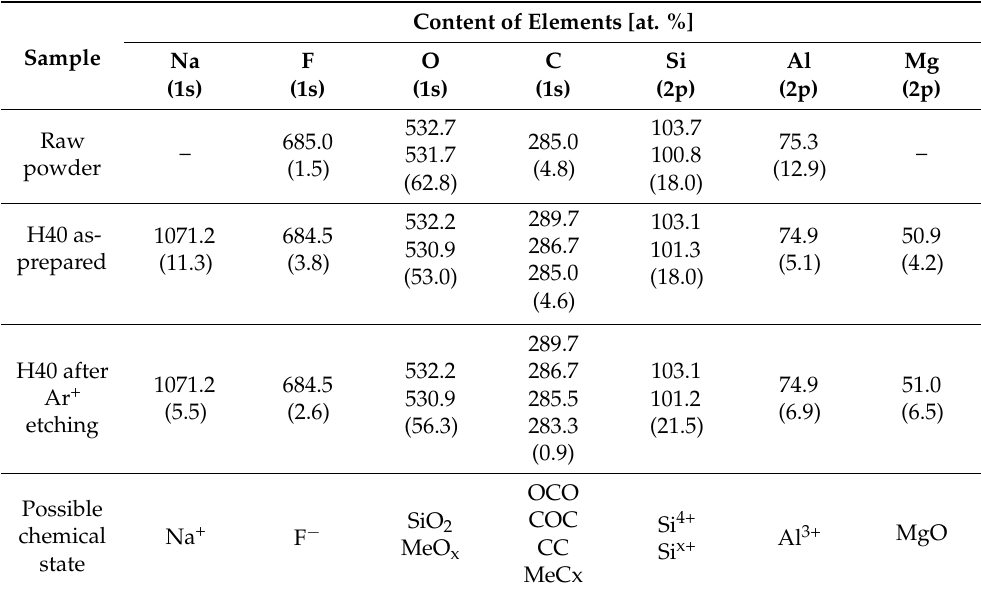
Table 3. Binding energy [eV] and the concentration of the main elements [at. %] for the raw halloysite nanotubes powder and H40